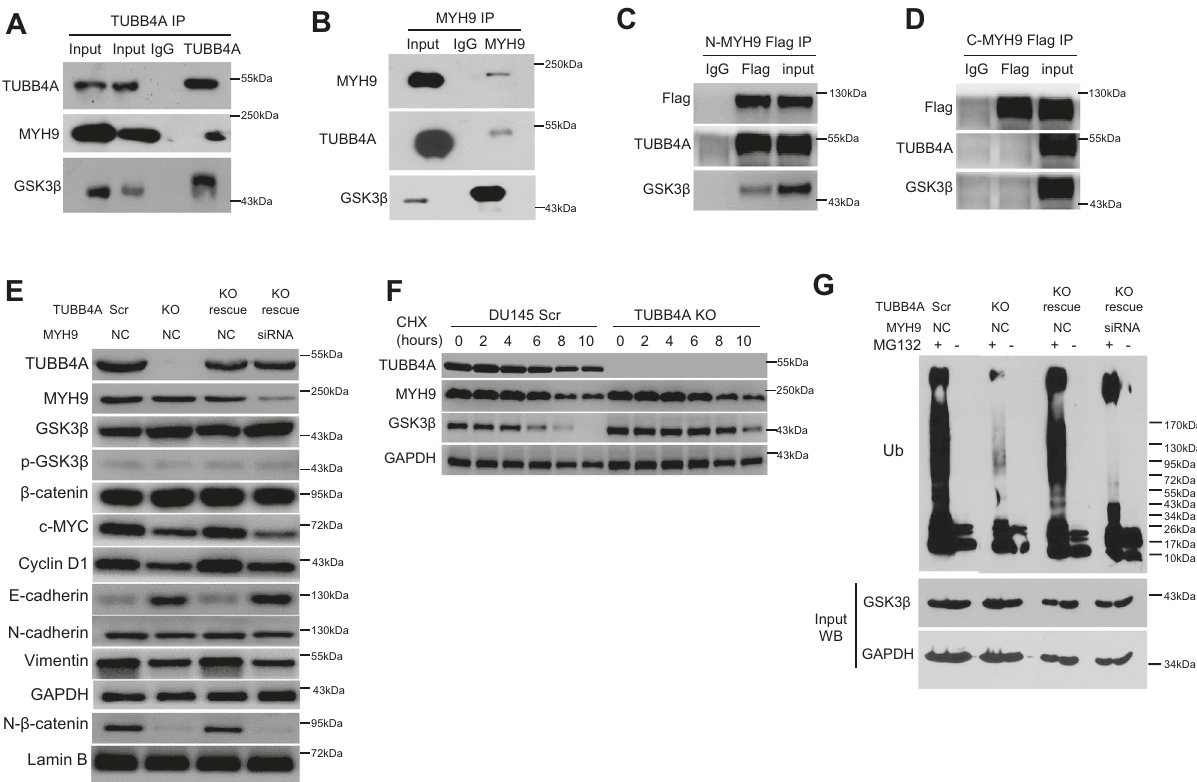
Fig. 5 TUBB4A/MYH9-regulated GSK3 β / β -catenin signaling pathway in prostate cancer cells. A , B Co-IP assay of TUBB4A and MYH9 in DU145 cells. The input was diluted at 1/10. C , D Co-IP assay of TUBB4A and N-terminal (N-MYH9) or C-terminal (C-MYH9) of MYH9-Flag in DU145 cells. E Western blotting for changes in proteins of the GSK3 β / β -catenin signaling pathway and EMT markers in DU145 cells with or without TUBB4A and MYH9 . F Western blotting showing the effect of TUBB4A KO on MYH9 and GSK3 β stability in DU145 cells incubated with cycloheximide (CHX) at the indicated time points. G Ubiquitination of GSK3 β in DU145 cells with or without TUBB4A and MYH9 . Cells were either untreated or treated with proteasome inhibitor MG132 (10 μ M) for 12 h. Equal aliquots of the cellular lysates were immunoprecipitated with anti-GSK3 β antibodies. Source data are provided as a Source data fi le. Scr, scramble; KO, knockout; NC, negative control siRNA; siRNA, small interfering